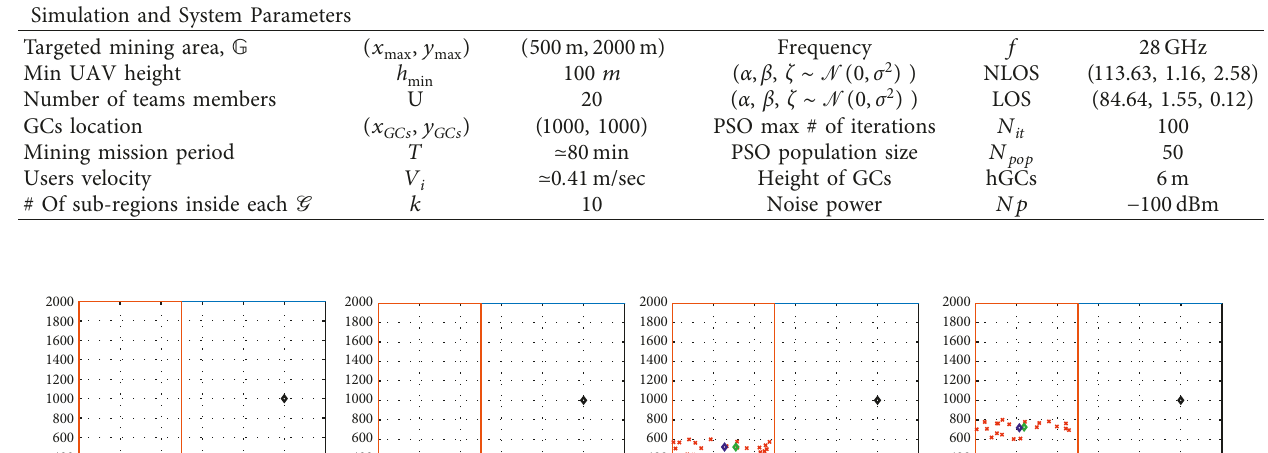
Table 1: Simulation and system